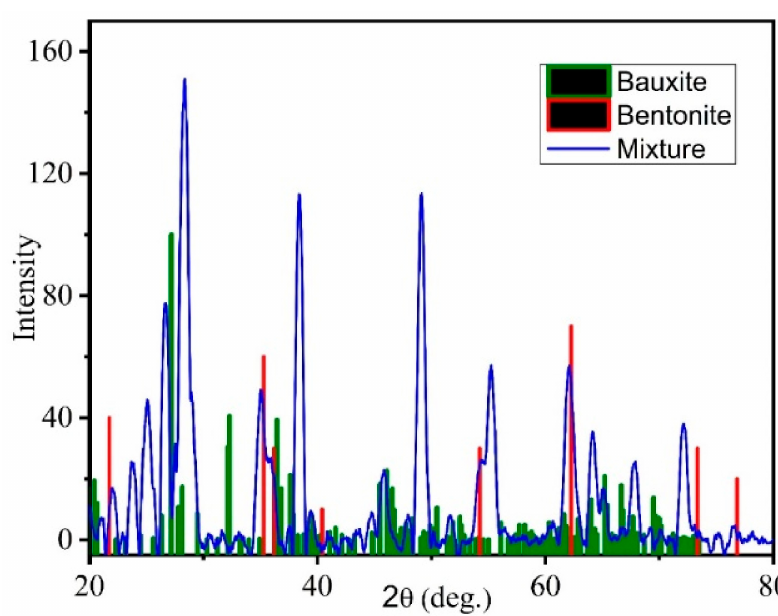
Figure 19. XRD of bauxite and